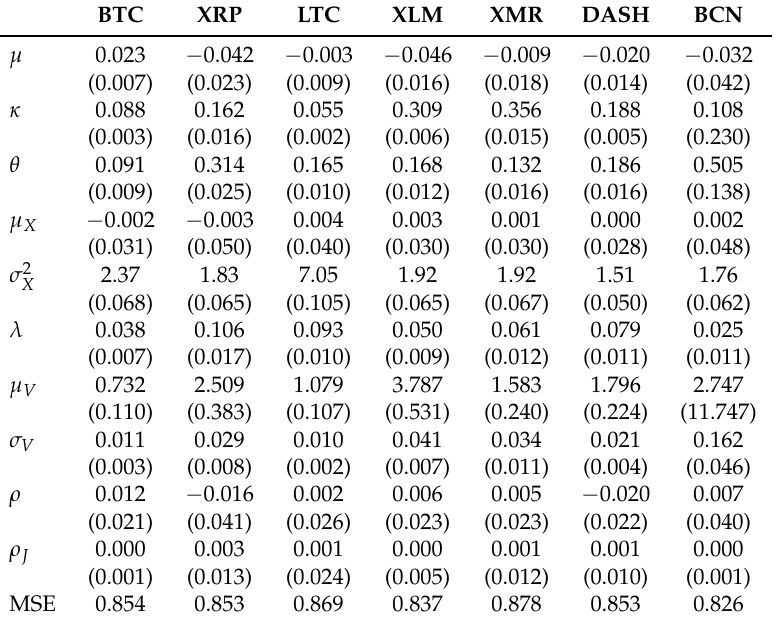
Table 2. Parameter estimates of stochastic volatility with co-jumps (SVCJ).